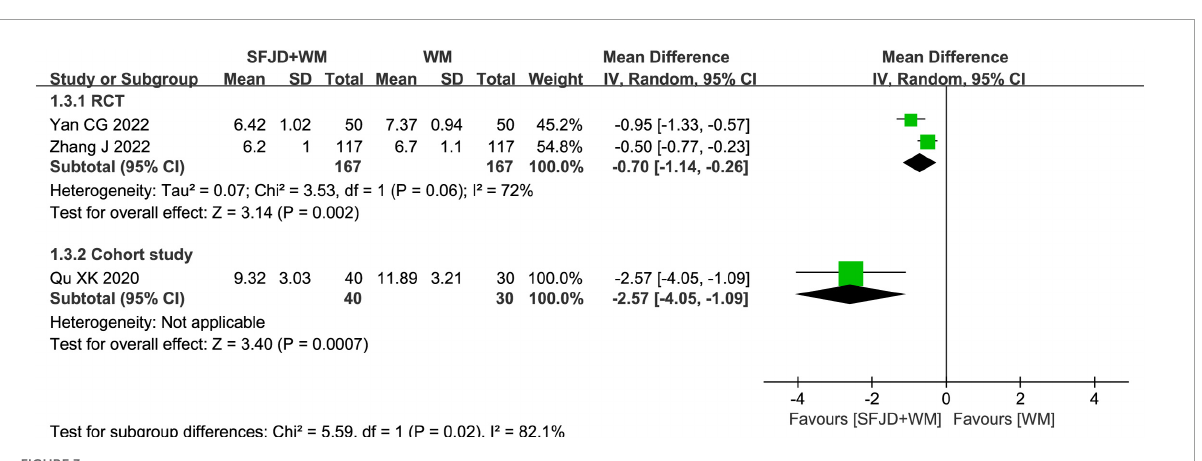
FIGURE3 Meta-analysis of nucleic acid conversion time in the SFJD + WM group vs. the WM group in COVID-19